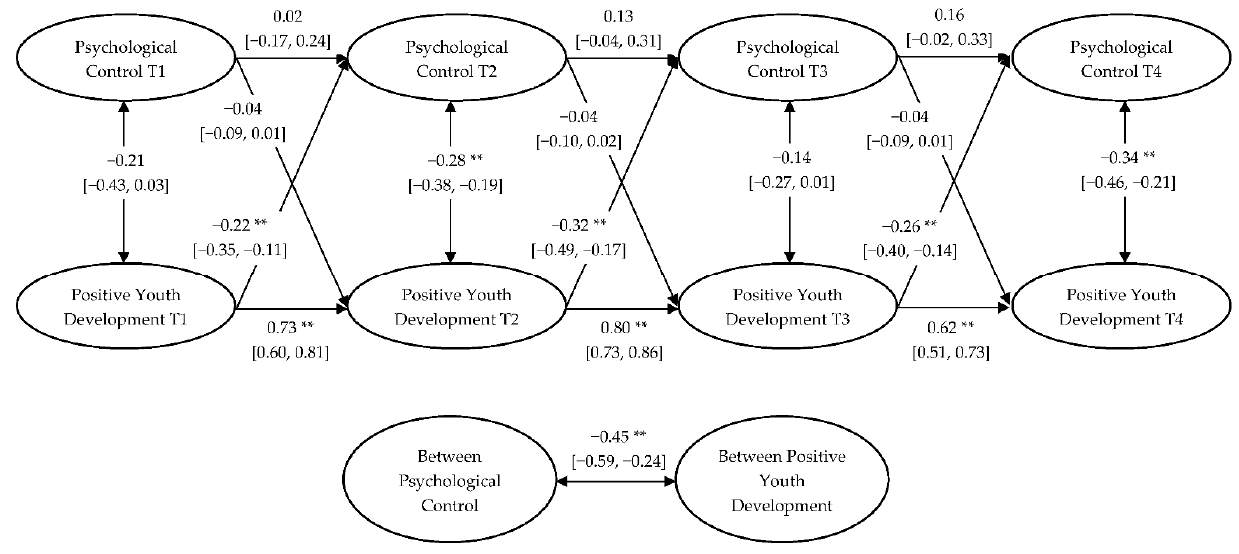
Figure 2. Simplified random intercept cross ‐ lagged panel model between perceived psychological control and Positive Youth Development with standardized coefficients. Note: Cross ‐ lagged paths are fixed to be equal between time points; the discrepancies are due to standardization. N = 454. ** p < 0.001.